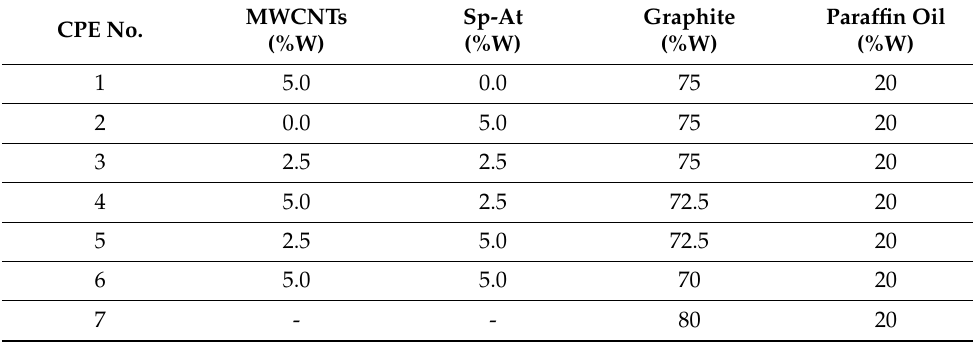
Table 1. Different CPE component